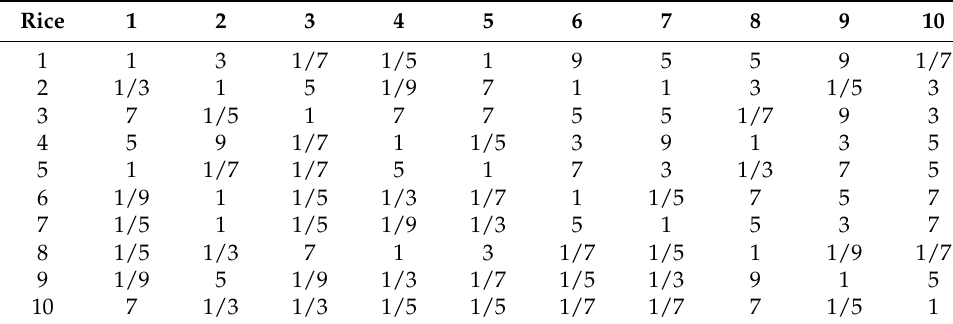
Table A14. Pairwise comparisons matrix of rice.